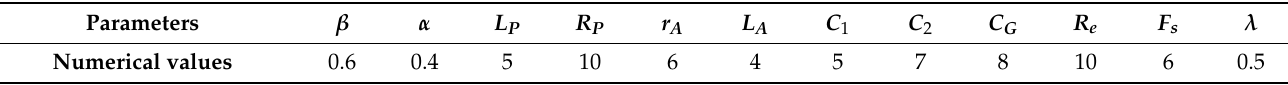
Table 4. Parameter assignment for A 8 ( 1,1,0 )